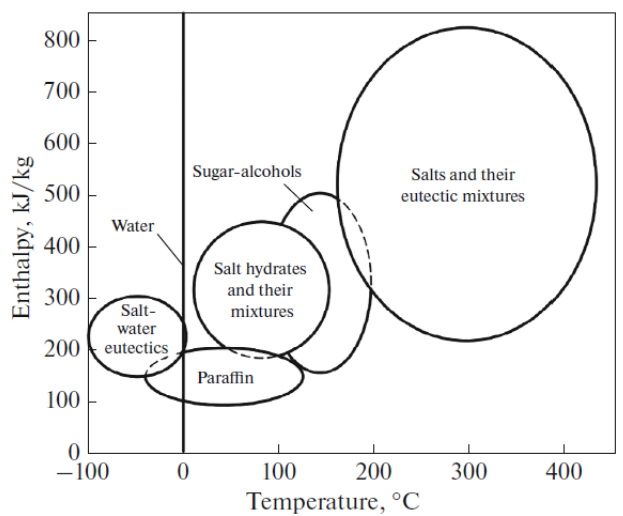
Figure 1. Relationship between the melting enthalpy and phase transition temperature for different types of PCM [38]. Table 1. Thermophysical properties of commercial paraffin waxes [27] with a specific heat capacity of 2.1 J/g K.